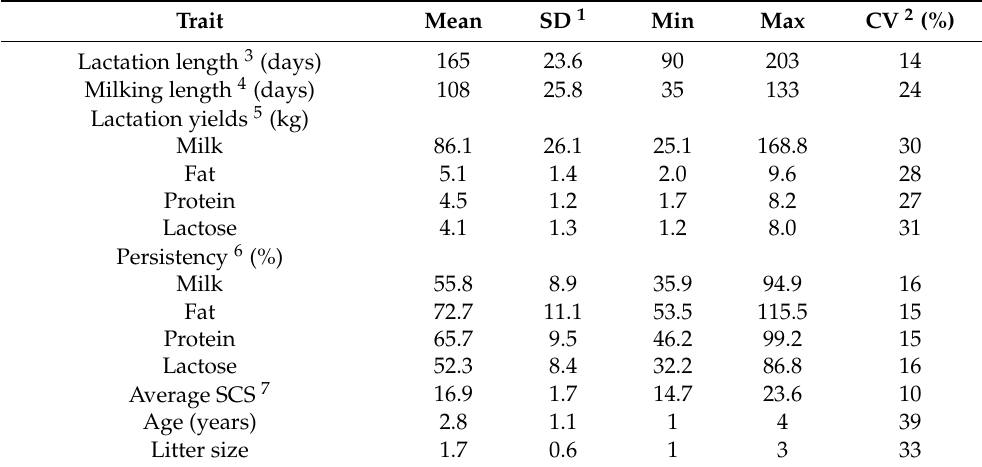
Table 2. Descriptive statistics of production variables considered in the genetic evaluation of Dairymeade sheep in 2021–2022 season (n = 169 lactations).